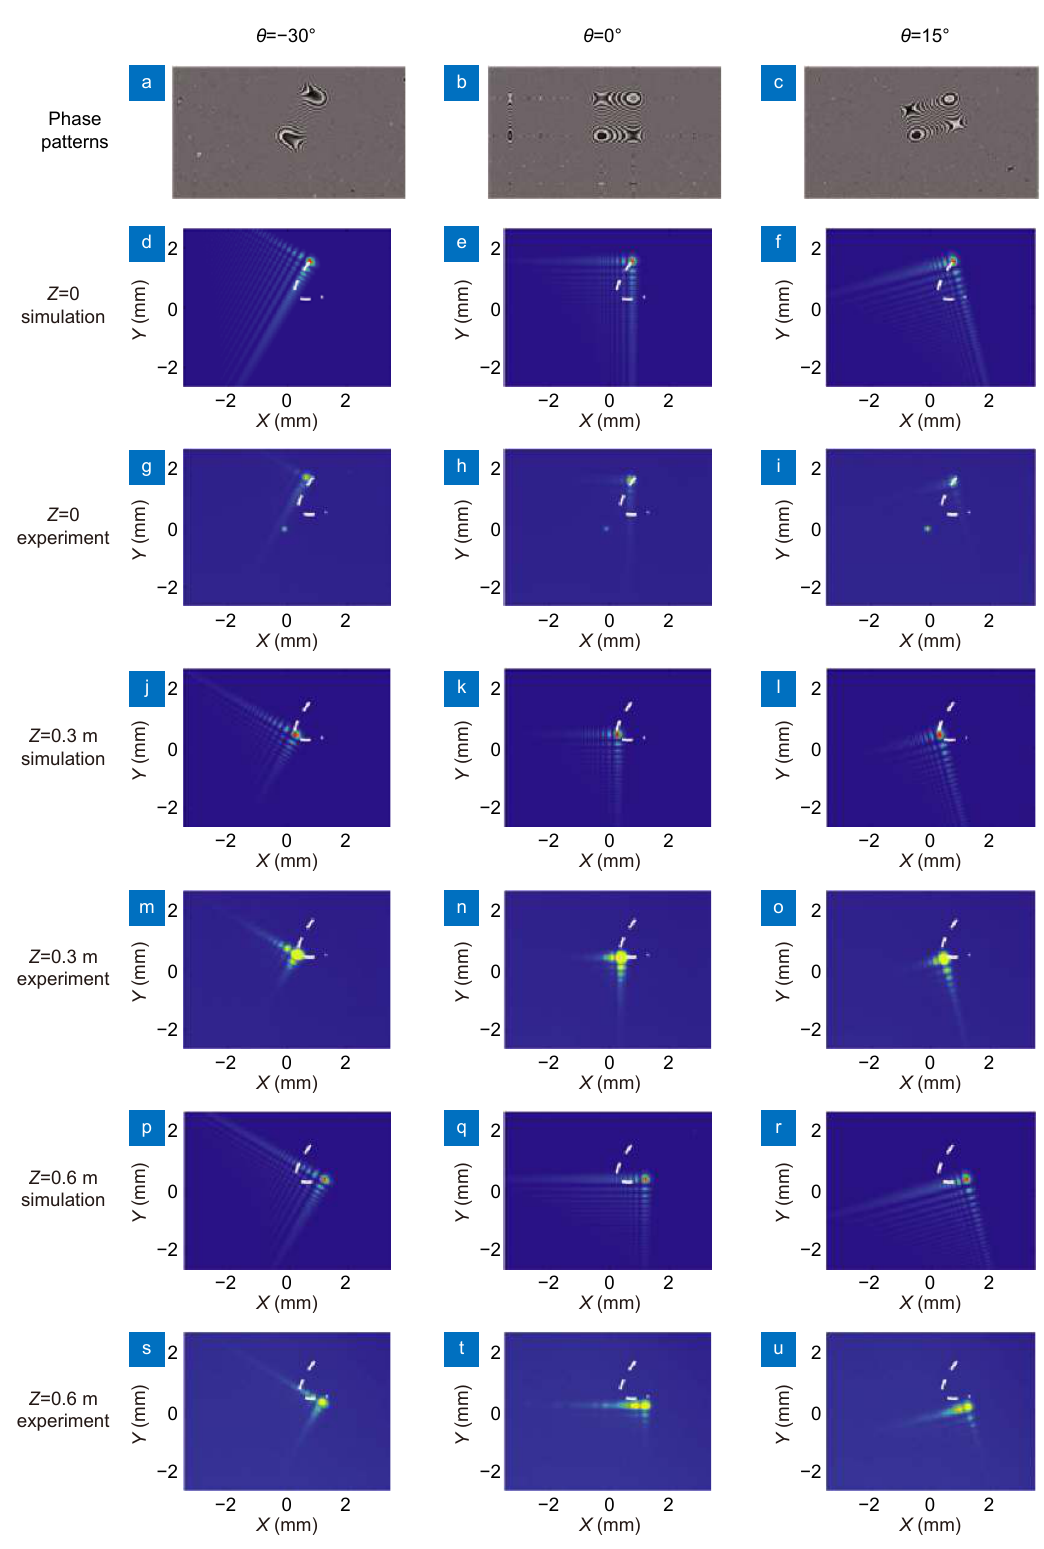
Fig. 4 | Calculated and experimental results for the optical field rotation of 2D Airy beam at different propagation distances. ( a − c ) Cal- culated phase patterns. ( d − f ), ( j − l ), ( p − r ) Simulated and ( g − i ), ( m − o ), ( s − u ) experimental intensity profiles at distance of 0, 0.3 m and 0.6 m with a rotation angle of -30°, 0° and 15°,